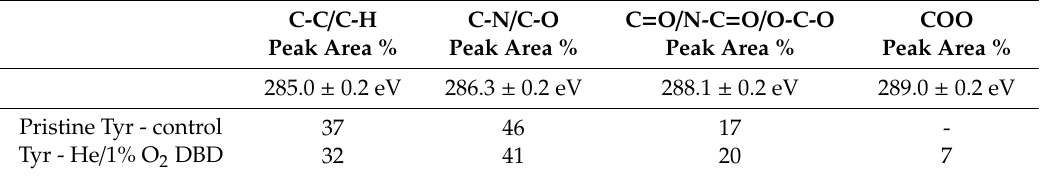
Figure 6. High-resolution X-ray photoelectron spectroscopy (XPS) C 1s spectra of a 5 µ g Tyr deposit ( a ) before and ( b ) after exposure to a DBD fed with He / 1% O 2 mixture for 30 min (f = 20 kHz, V a = 1.1 kV rms ). Table 3. Curve fitting results of high-resolution C 1s XPS spectra of the dry Tyr deposit before and after 30 min exposure to the DBD fed with He / 1% O 2 mixture (f = 20 kHz, V a = 1.1 kV rms ).